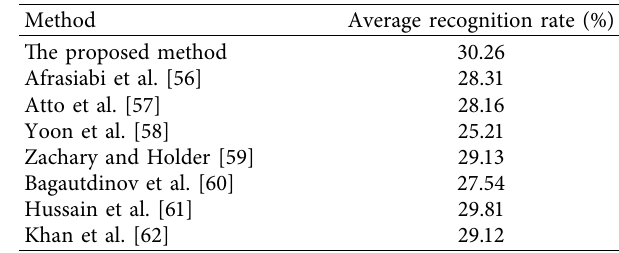
Table 5: Compared with other approaches on the TV human interaction dataset (strong occlusion and high dynamic video).